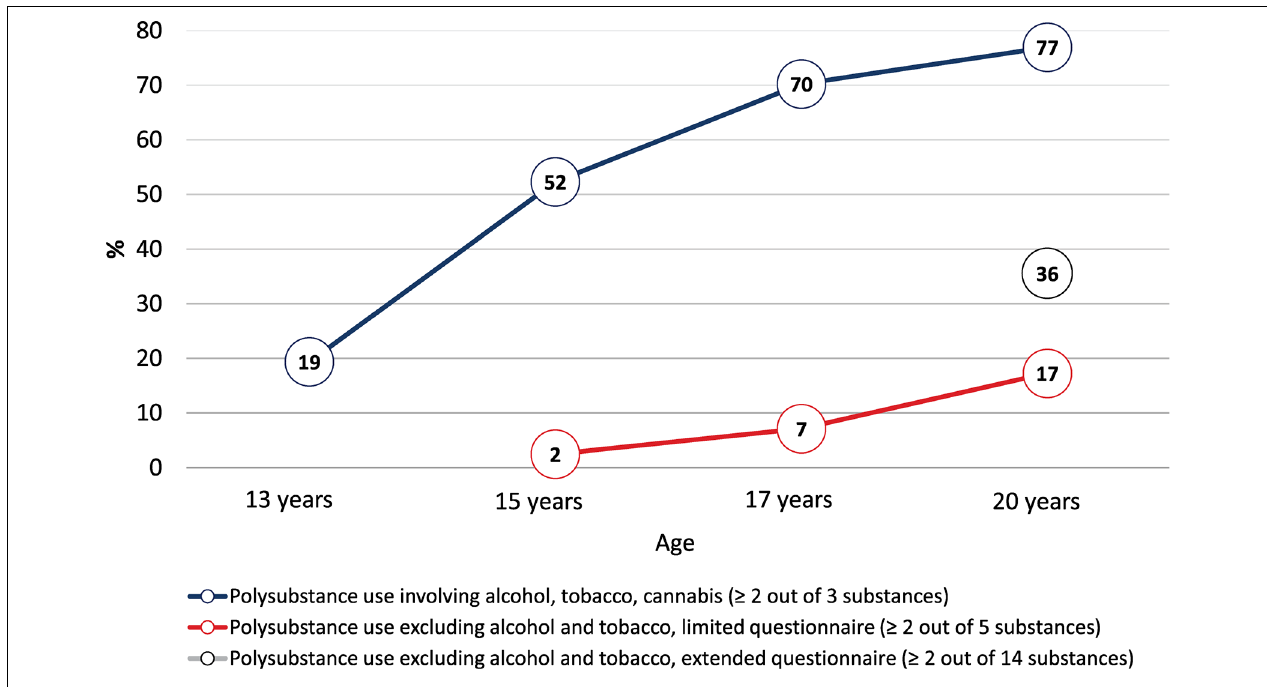
FIGURE 1 | Prevalence of polysubstance use between ages 13 and 20 years. Note . The prevalence of polysubstance use at age 20 was 25% when cannabidiol (CBD) was excluded.